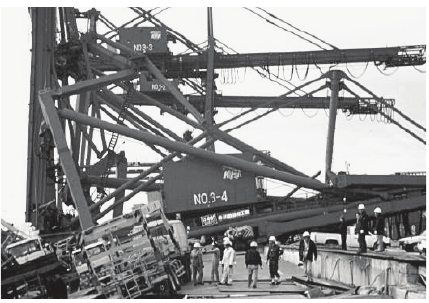
Figure 1: Collapsed cranes at Kobe